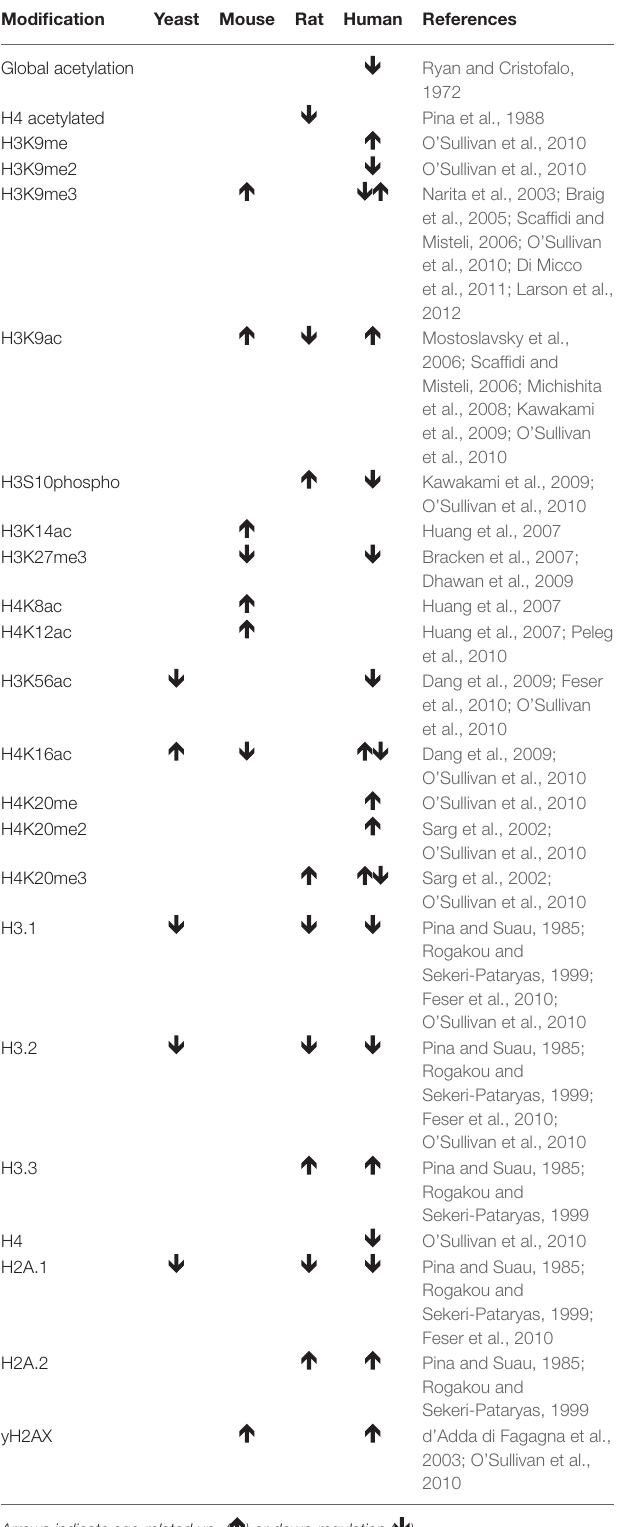
TABLE 1 | Changes in histone modification pattern and nucleosome occupancy with increasing age and senescence.